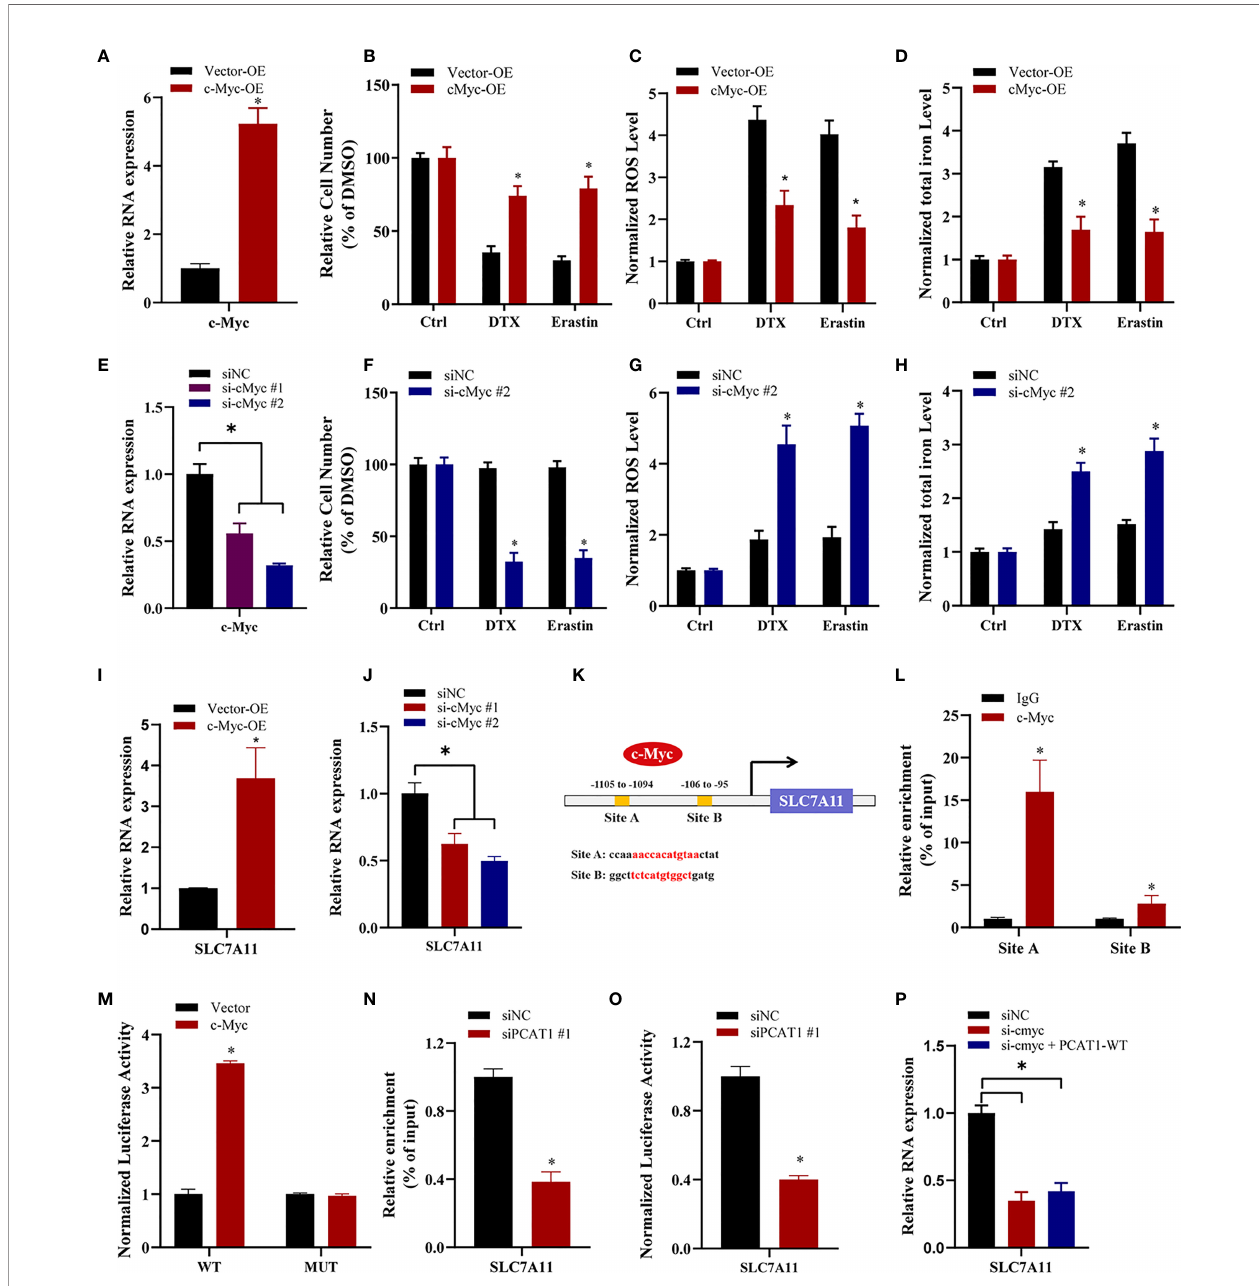
FIGURE 6 | c-Myc transcriptionally promotes SLAC7A11 expression to inhibit ferroptosis and DTX resistance. (A) c-Myc overexpression PC3 cells were successfully established. (B – D) The cell viability, lipid ROS content and total iron concentration were assessed in PC3 cells after c-Myc overexpression upon DTX and erastin treatment. (E) c-Myc level was successfully reduced in PC3/DR cells by transfecting si-cMyc and control siRNA. (F – H) The cell viability, lipid ROS content and total iron concentration were assessed in PC3/DR cells after c-Myc knockdown upon DTX and erastin exposure. (I, J) The mRNA levels of SLC7A11 was evaluated by qRT-PCR upon c-Myc overexpression or knockdown. (K) Schematic diagram showing the location of c-Myc binding sites on the promoter regions of SLC7A11. (L) ChIP-qPCR was used to detect the binding ef fi ciency of c-Myc on the SLC7A11 promoter. (M) The luciferase activities were measured in c-Myc overexpressed PC3 cells after co-transfected with SLC7A11 wild-type (WT) and mutant (MUT) plasmids. (N, O) The binding ability of c-Myc on the SLC7A11 promoter and luciferase activities of SLC7A11-WT plasmids were detected in PC3/DR cells after PCAT1 knockdown, respectively. (P) qRT-PCR assay was used to detect the expression of SLC7A11 in c-Myc-knockdown PC3/DR cells after co-transfected with PCAT1 plasmids. The data are presented as the means ± S.D. of at least three independent experiments. * P